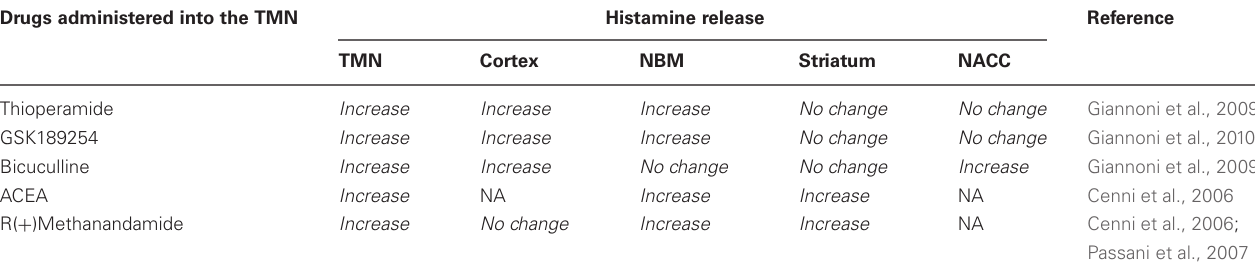
Table 1 | Influence of drug administration into the TMN on histamine release from different brain areas of freely moving rats. Drugs administered into the